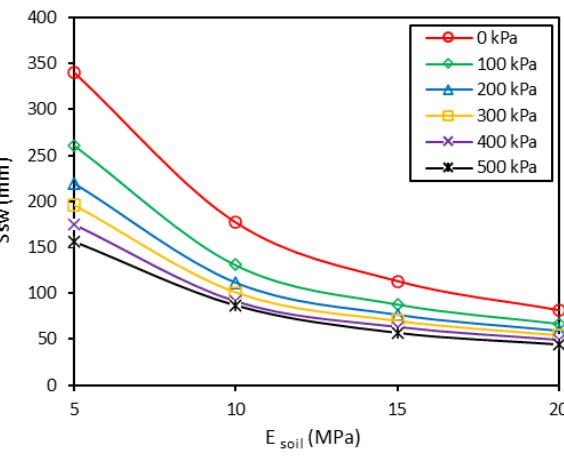
Figure 13: Variation of square footing heave S soil stiffness E for σ =0 to 500 kPa. soil 0